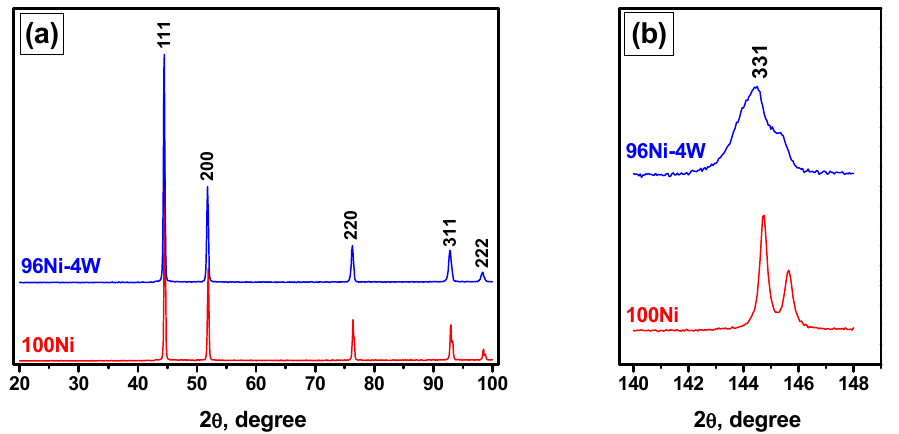
Figure 2. XRD profiles for 96Ni-4W alloy and 100Ni: survey patterns ( a ) and 331 reflections in the far angle range ( b ).